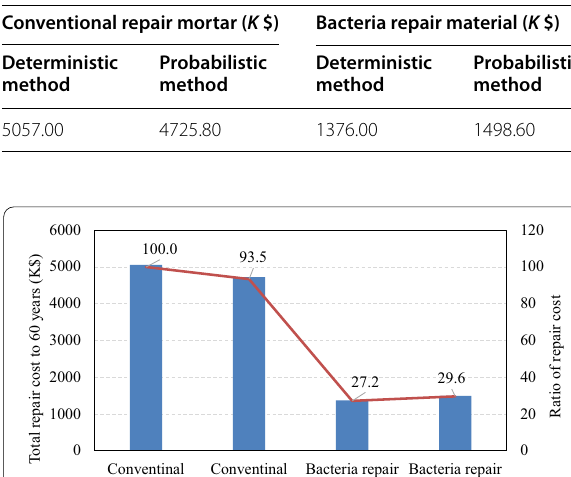
Table 5 Total repair cost to intended service life.